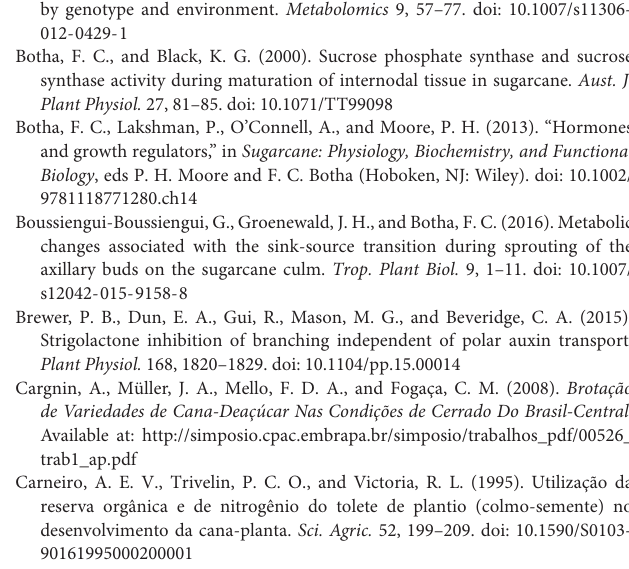
FIGURE S1 | Pedigree of the sixteen selected sugarcane genotypes and their corresponding parentals. Gray circles represent parental genotypes that were not evaluated in this study; red, orange, blue, and green circles are genotypes ranked as low, intermediate-low, intermediate-high, and high sprouting, respectively. The arrows connecting genotypes are in the same color as their respective relatedness. FIGURE S2 | Numerator relationship matrix among selected sugarcane commercial cultivars. The colors indicate the grade of relationship from low (red) to high (blue). FIGURE S3 | Box plots of sprouting index of the sixteen selected sugarcane genotypes. For comparison among cultivars, the sprouting average considering the quartile analysis to classify them as low, intermediate-low, intermediate-high, and high sprouting was plotted. The groups are displayed in red, orange, blue, and green, respectively. FIGURE S4 | Effect of genotypes on the levels of individual metabolites. Histograms show the number of metabolites whose levels changed according to the significance indicated by P -values. Bonferroni-corrected ANOVA was used to evaluate the effects of genotypes on culm (A) and bud (B) . TABLE S1 | Summary of the selected sugarcane genotypes and classification of their agronomic traits. Genotypes are coded from 1 to 16 and ranked as low (red), median-low (orange), intermediate-high (blue), and high sprouting (green) ability. ∗ POL: percentage by weight of apparent sucrose; 1 Data obtained from RIDESA breeding program (Carneiro, personal communication). 2 Data obtained from greenhouse experiments performed in this study. TABLE S2 | Levels of all detected metabolites in culm and bud of the selected sugarcane cultivars. TABLE S3 | Metabolite–metabolite correlations for bud, culm, and common to both tissues. Significant pairwise correlations within and between tissues ( r ≥ 0.5, p ≤ 0.05) were highlighted in blue and yellow, representing positive and negative correlations,